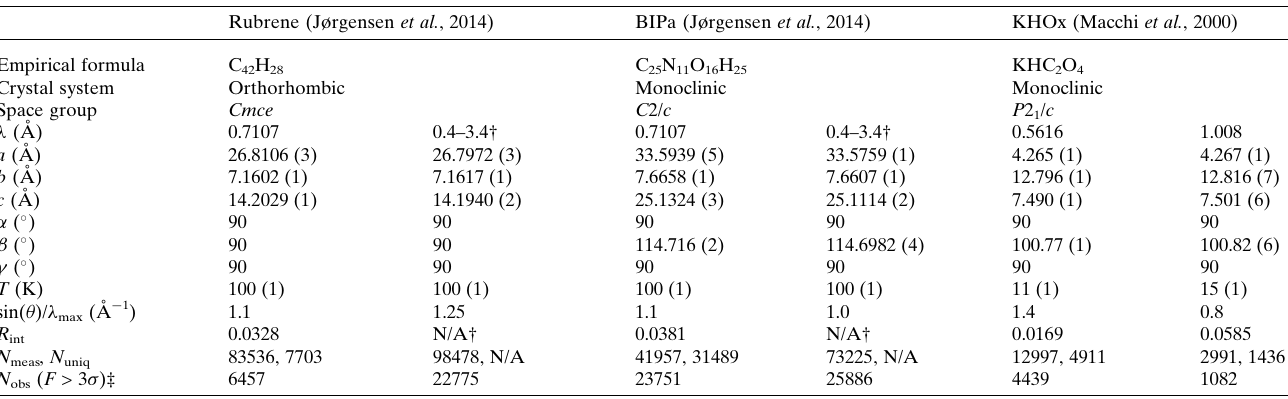
Table 2 Crystallographic information and measurement details of rubrene, BIPa and KHOx. The first column for each compound refers to X-ray data and the second column to neutron measurements. Rubrene (Jørgensen et al. , 2014) BIPa (Jørgensen et al. , 2014) Empirical formula